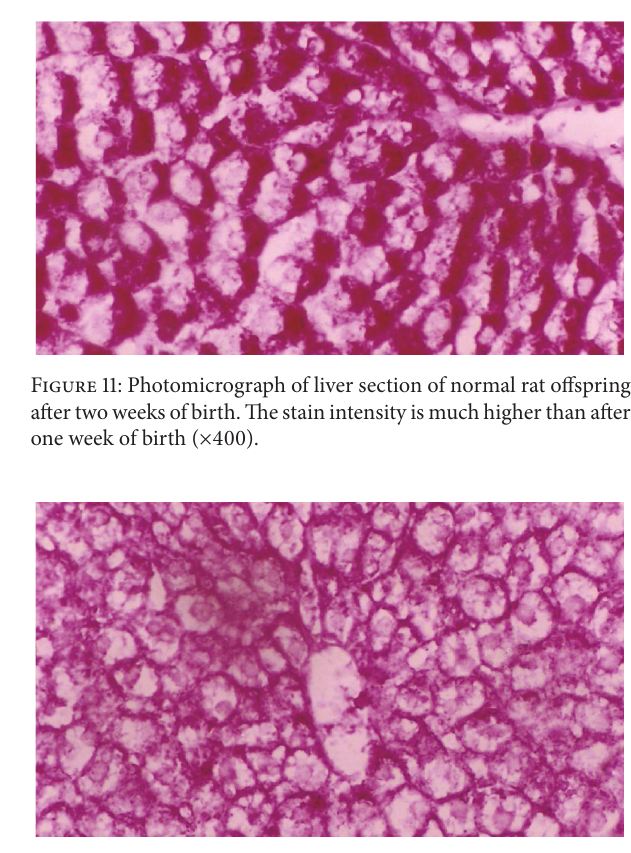
Figure 12: Photomicrograph of liver section of diabetic rat offspring after two weeks of birth. The stain is less intensive than after one week of birth ( ×